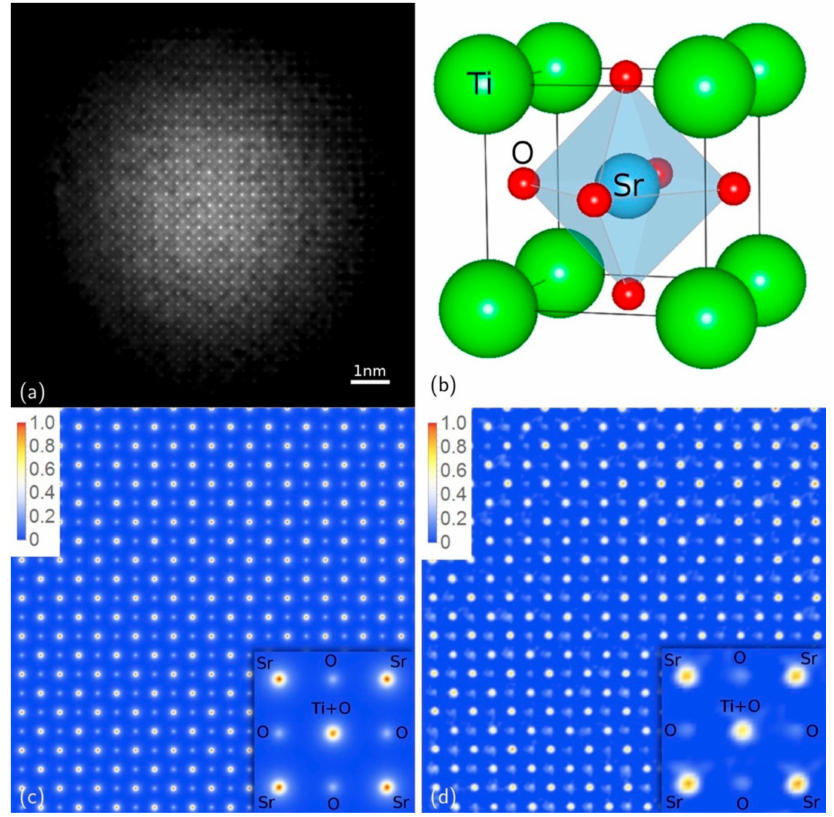
Figure 4. ( a ) Modulus of the retrieved scattering function (relevant to Figure 3); ( b ) SrTiO 3 unit cell; ( c ) simulation of the SrTiO 3 projected potential in [001] zone axis and ( d ) experimental data extracted from the phased map. (Reprinted with permission from Colombo et al.